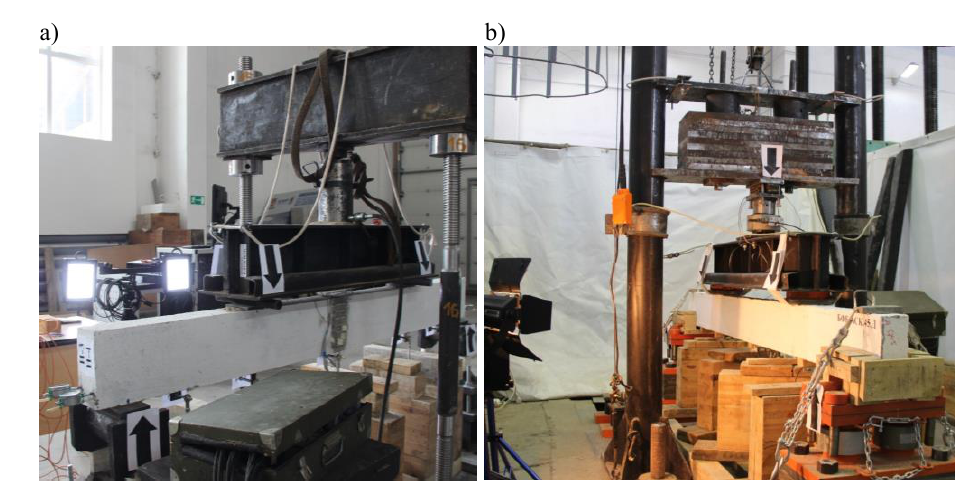
Fig. 2. General views of testing of bent BFC-GFRP elements with static load (a) and short-term dynamic load